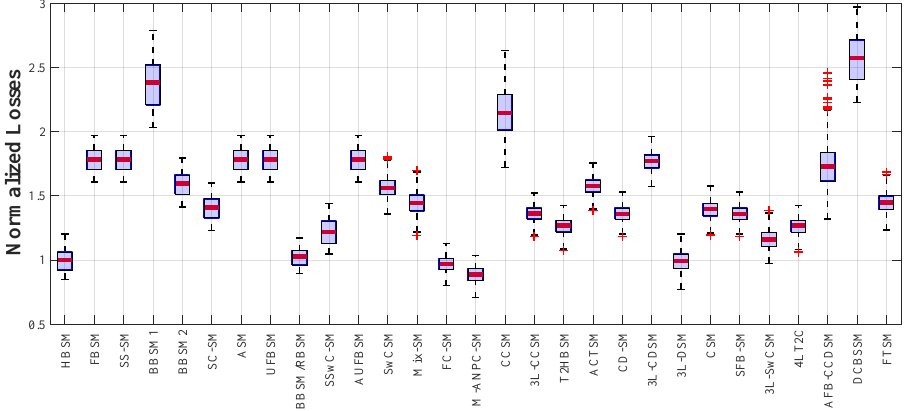
Figure 22. Losses of SMs over 1000 consecutive periods at unity power factor (rectifier).